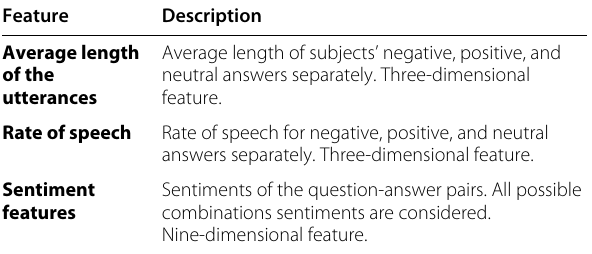
Table 2 Descriptions of the text features derived from